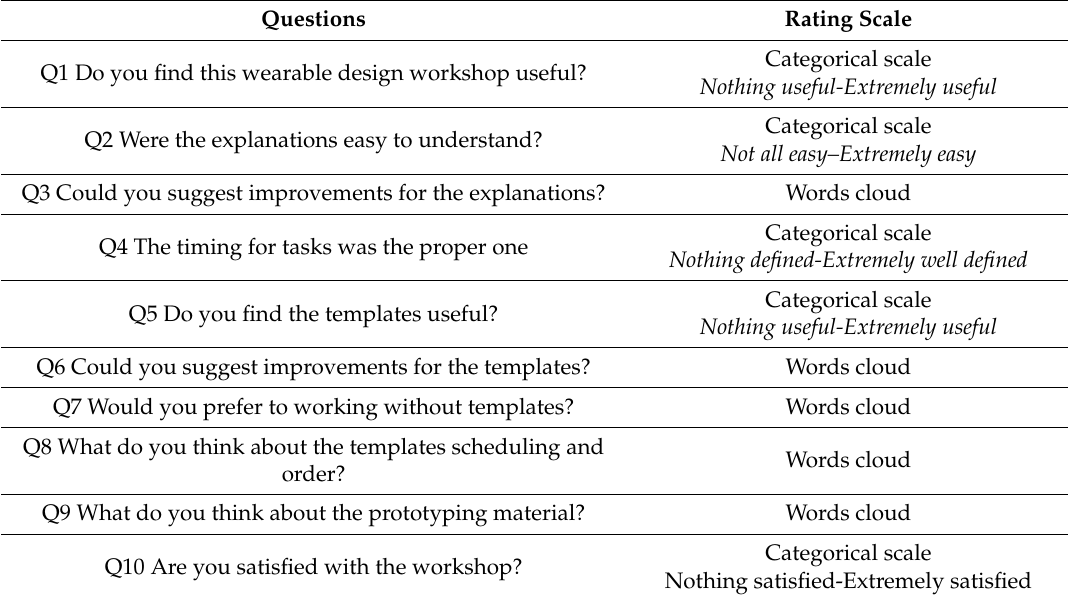
Table 4. Questions formulated in the online